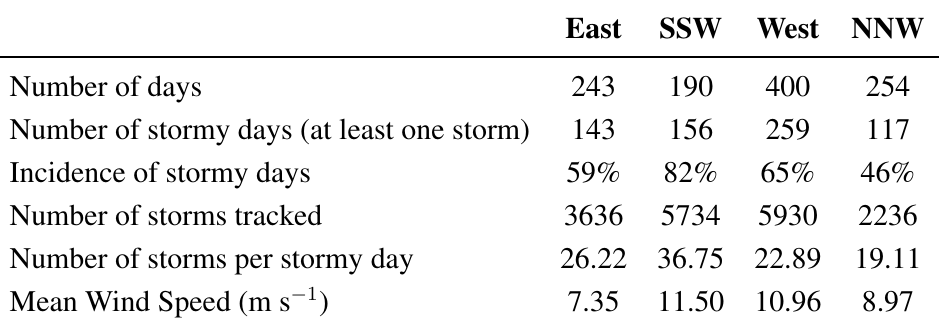
Table 4. Statistics on the occurrence of storms and upper air winds (based on radiosounding mean wind between 700 and 500